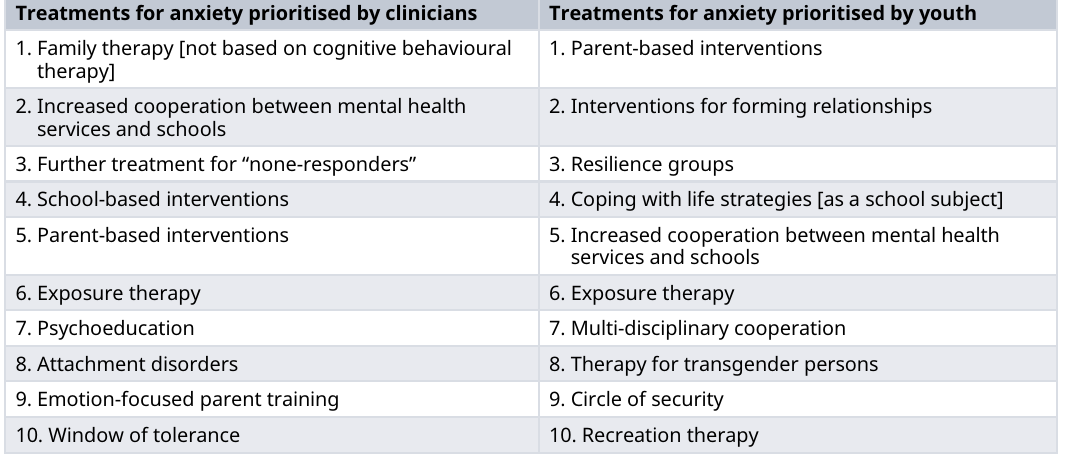
Table 3. Prioritised treatments for anxiety. Treatments for anxiety prioritised by clinicians